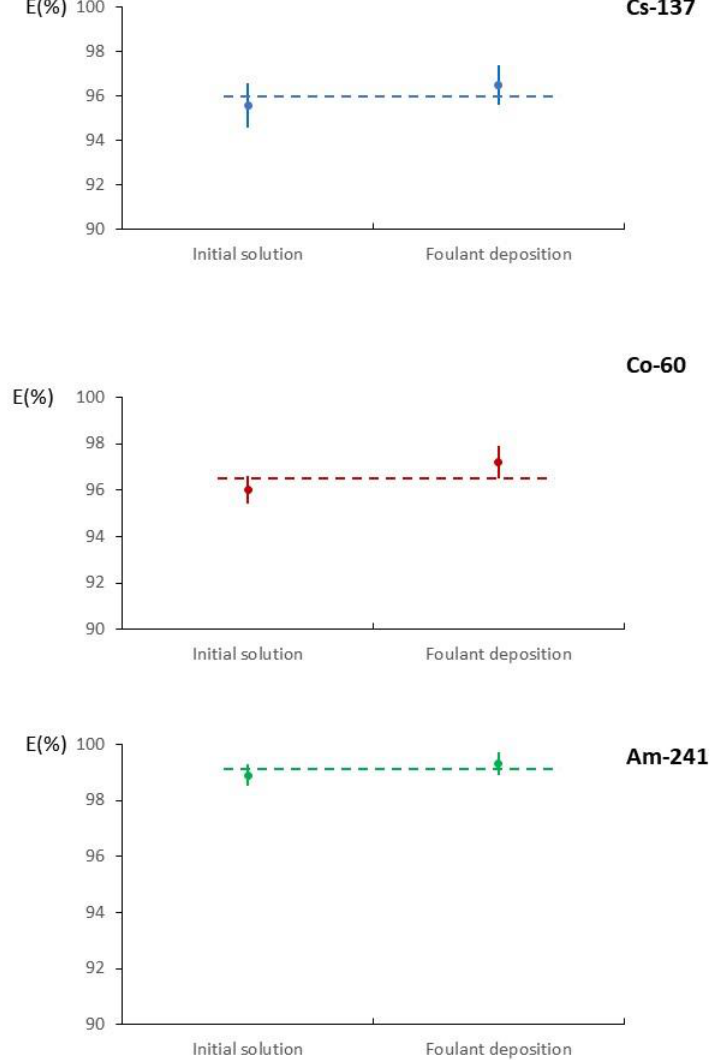
Figure 6. Changes in the purification efficiency, E (%), of three radioactive metal cations because of the membrane fouling.